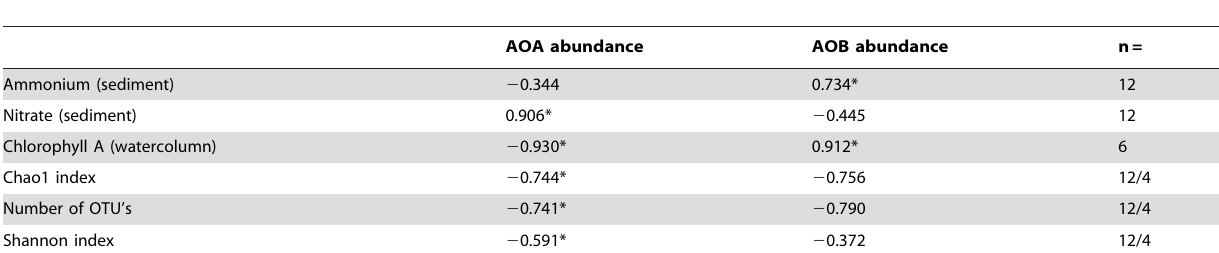
Table 2. Pearson correlations of AOA and AOB abundances with environmental and alpha diversity data.